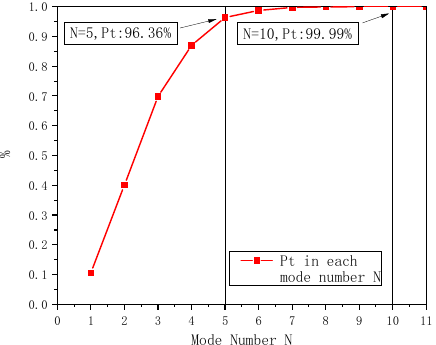
Figure 2. Comparison of the power spectrum distribution of the model with the presence of the plate and the model without the presence of the plate.